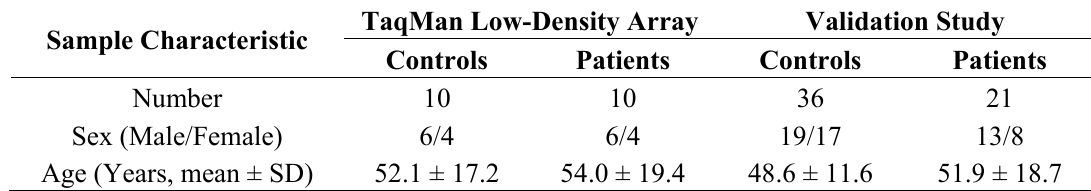
Table 1. The basic characteristics of healthy controls and patients with H7N9 virus